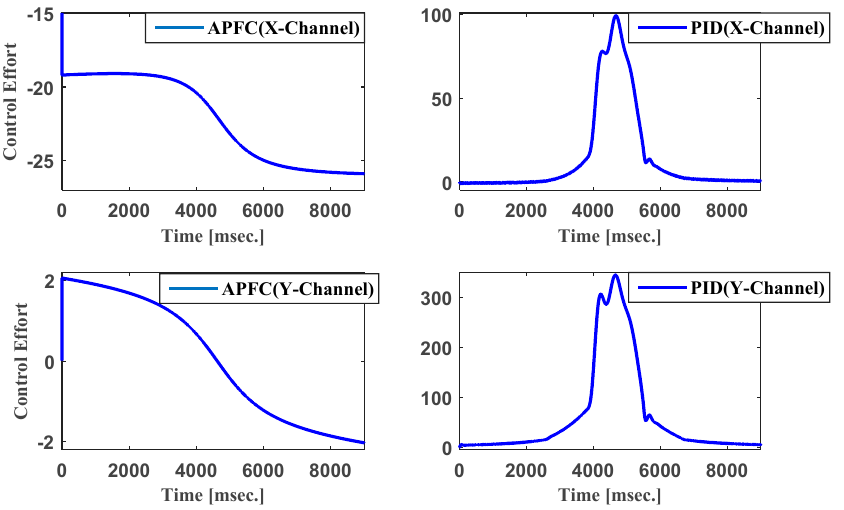
Figure 6. Control efforts generated by APFC scheme and PID controller.